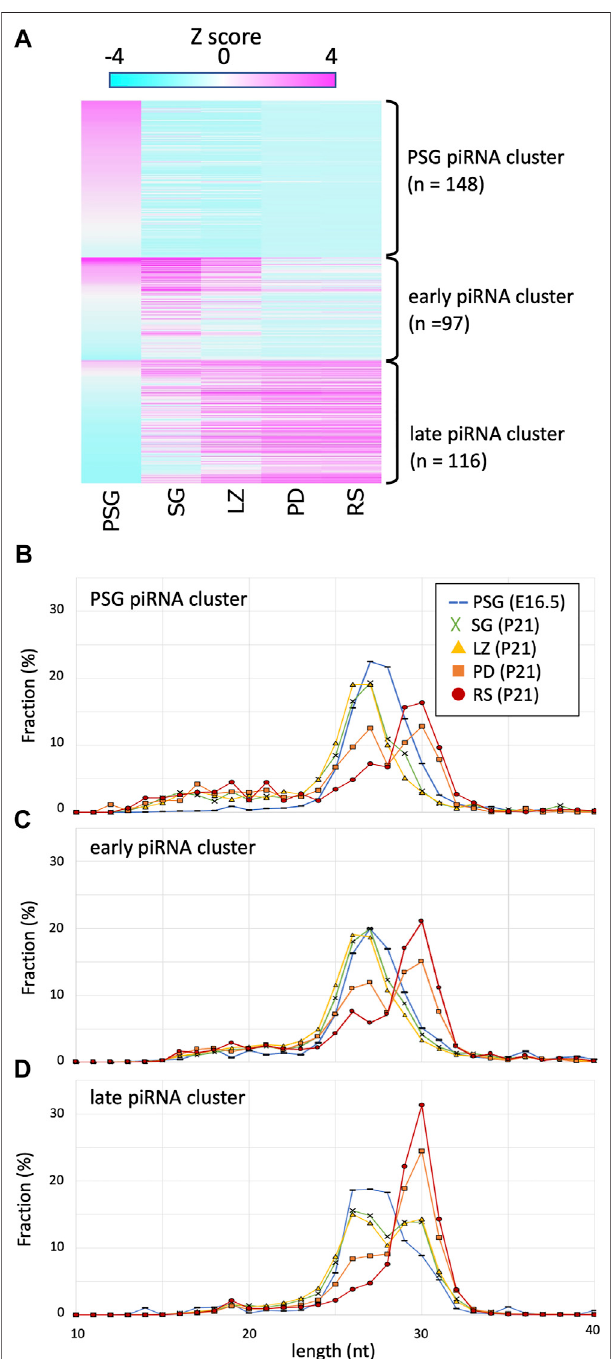
FIGURE 2 | Expression pro fi le and lengths of piRNA clusters. (A) A heatmapshowingthepiRNAexpressionlevelsfor512piRNAclustersindifferent developmental stages. The clusters are ordered by the three piRNA categories: PSG, early, late piRNA clusters. (B – D) Length distributions of piRNAs derivedfromPSG (B) ,early (C) ,andlate (C) piRNAclustersinthedevelopmental stages. The color codes are the same as those in Figure 1B .